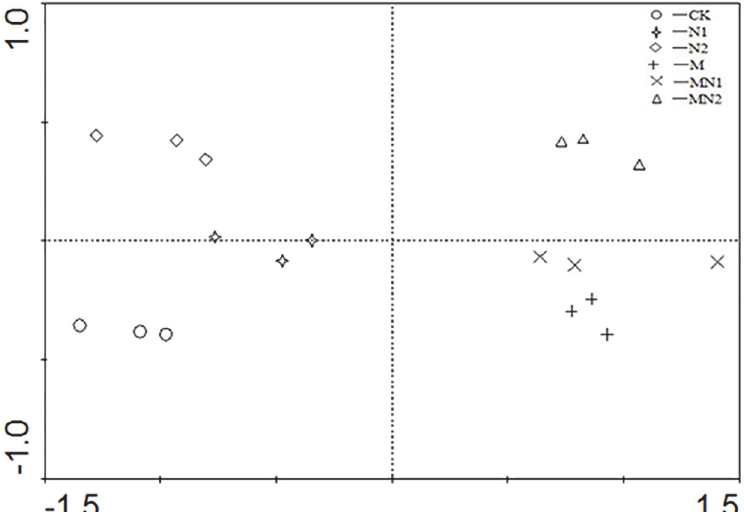
Fig 4. Principal component analysis of soil physical-chemical properties under the different treatments(CK unfertilized control; N1 300 kg fertilizer N ha -1 ; N2 600 kg fertilizer N ha -1 ; M composted manure; MN1 combined application of composted manure and 300 kg N fertilizer ha -1 ; MN2 combined application of manure and 600 kg fertilizer N ha -1 ).